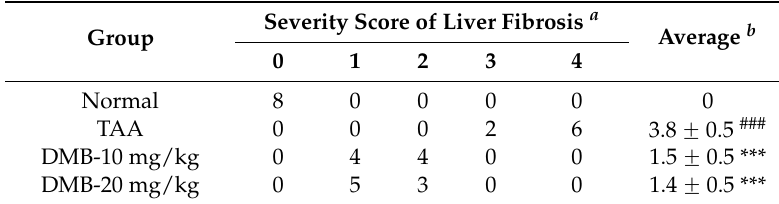
Table 3. The pathological score of TAA-induced liver fibrosis in mice. Severity Score of Liver Fibrosis a Group